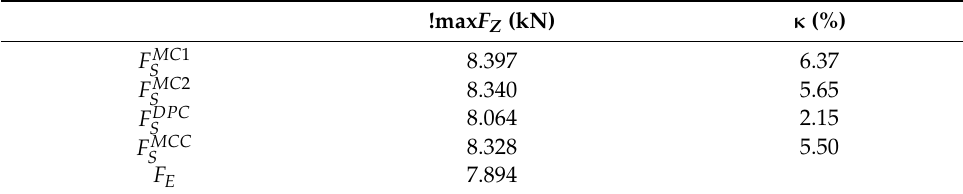
Figure 7. Change in the SSE value of MC1, MC2, DPC and CC in 1 mm intervals. The result show that the goodness of fit of the predictions given by the respective models with the experimental data varied depending on the section. In the case of CC model, the lowest value of SSE was obtained in the range of 86 – 88 mm. In the ranges 88 – 97 mm and 99 – 100 mm, the lowest SSE value was obtained for the DPC model. In the range of 97 – 99 mm, in turn, the lowest SSE value was obtained for the predictions ob- tained with the MC2 model.